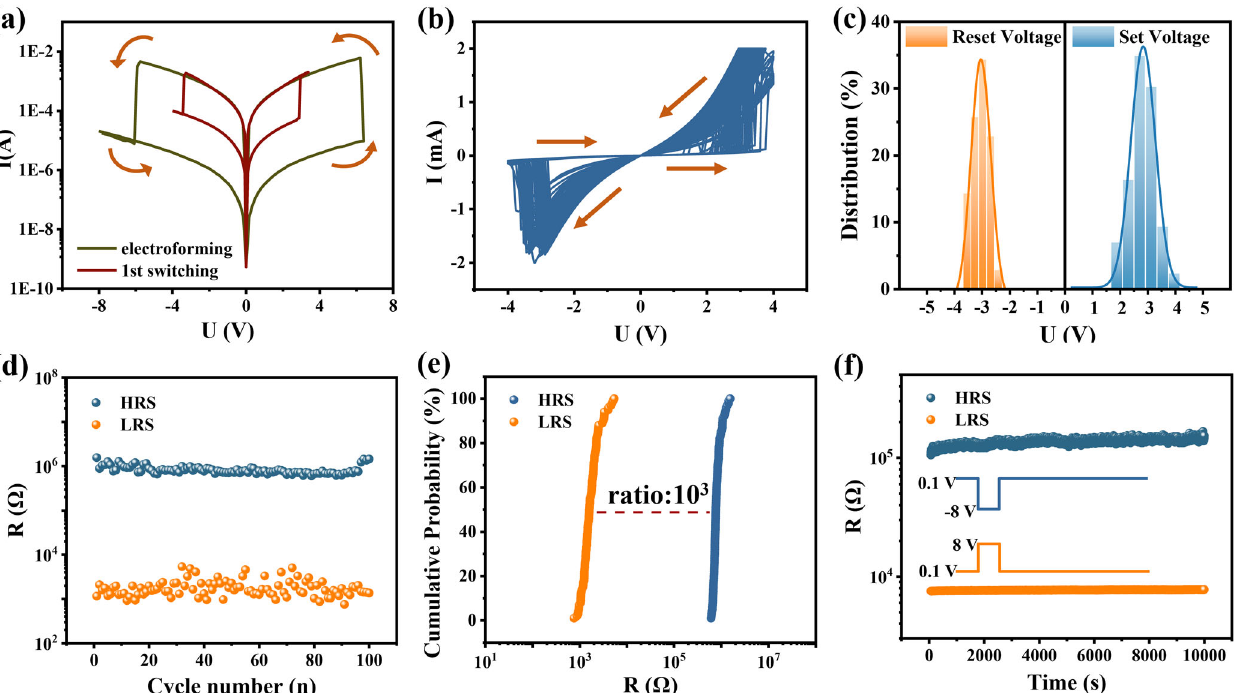
Fig. 2 Electrical characterizations of the memristor. a I - V switching curves of the device. The green and red line represents the electroforming and the 1st switching process, respectively. b I - V curves of the device for 100 consecutive cycles of sweep volatges. c The distribution of Set voltage and Reset voltage during 100 cycles. d Endurance characteristics undergoing 100 SET/RESET switching cycles. e Cumulative probability plots of HRS and LRS. f Retention performance of LRS and HRS after Set and Reset operations. The pulse voltages and read voltages are 8/ − 8 V, and 0.1 V,